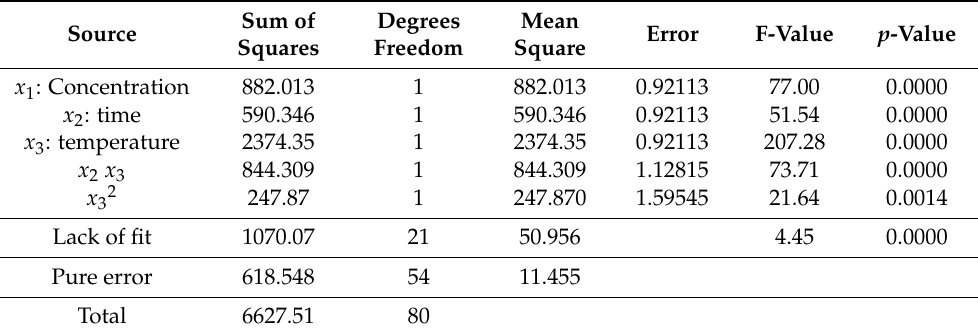
Table 2. Analysis of variance (ANOVA) for total phenolic compounds.